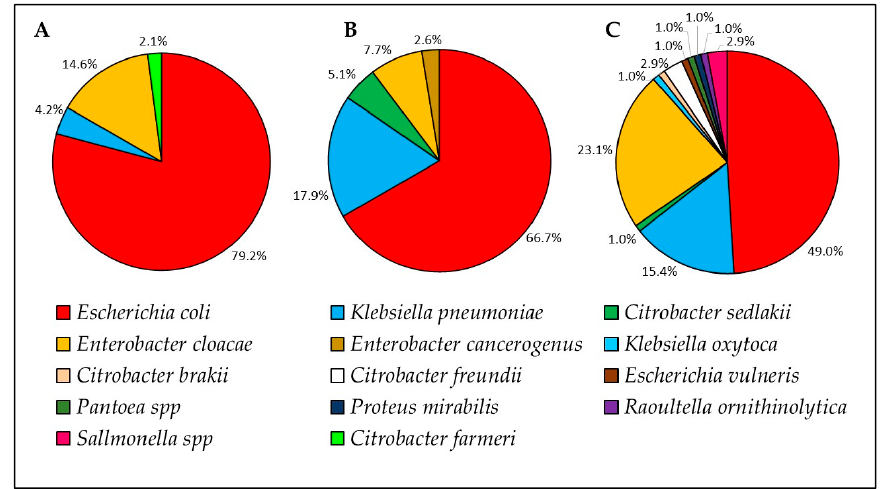
Figure 1. ESBL-E species distribution isolated from cohort (i) farm horses (( A ), n = 48 isolates), cohort (ii) horses on admission to the hospital (( B ), n = 39 isolates) and cohort (iii) 72 h post-admission (( C ), n = 105 isolates).